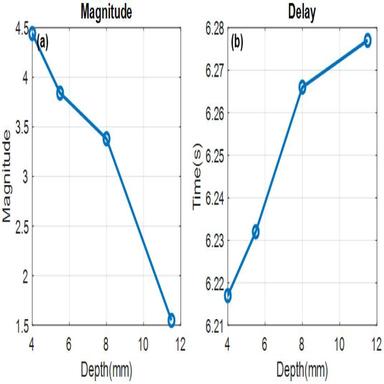
Time-of-flight feature against defect depth: (a) amplitude, (b) time delay.